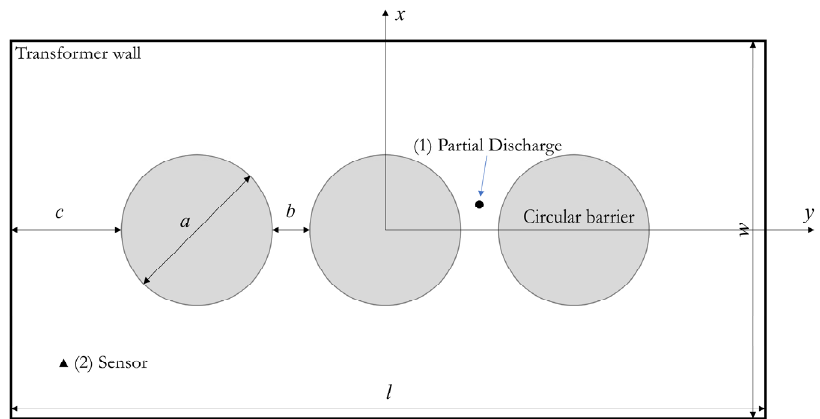
Figure 2. The geometry of the 2D transformer model.